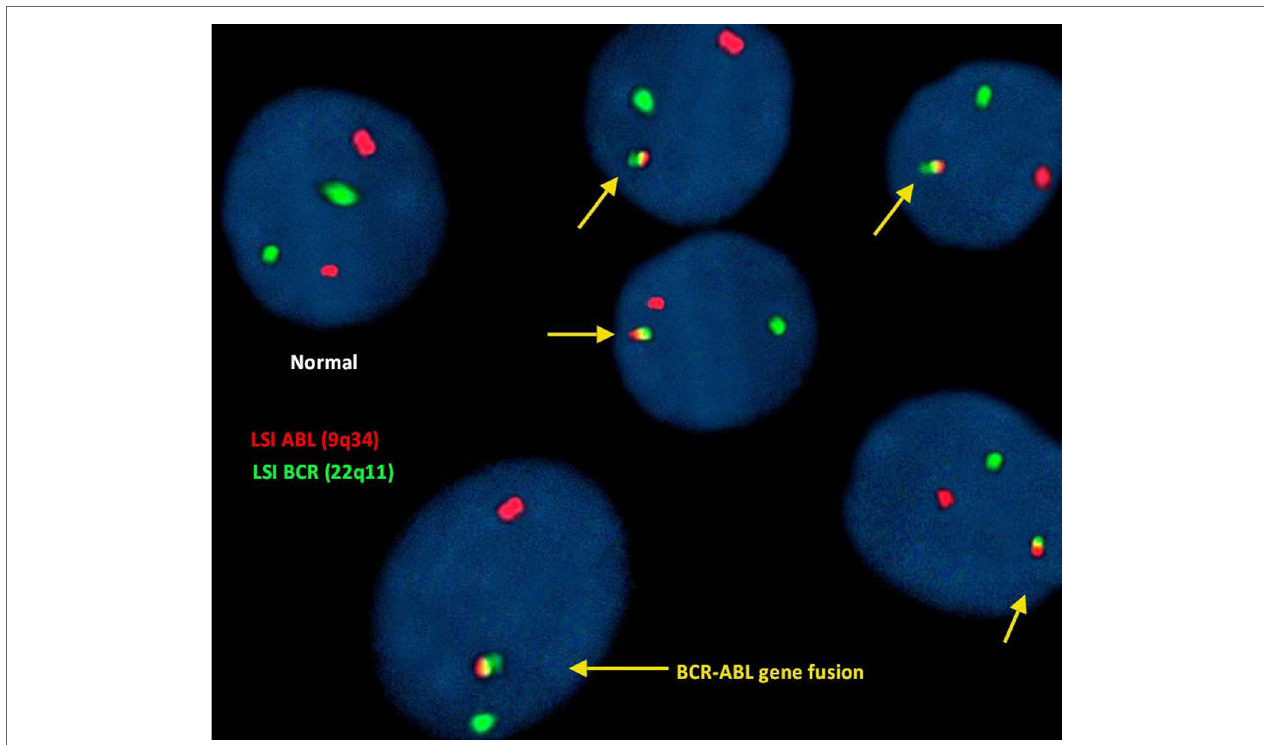
FIGURe 2 | Fluorescence in situ hybridization (FIsH) for the detection of (9;22)(q34;q11) . BCR–ABL translocation was detected in 91% of the 500 nuclei